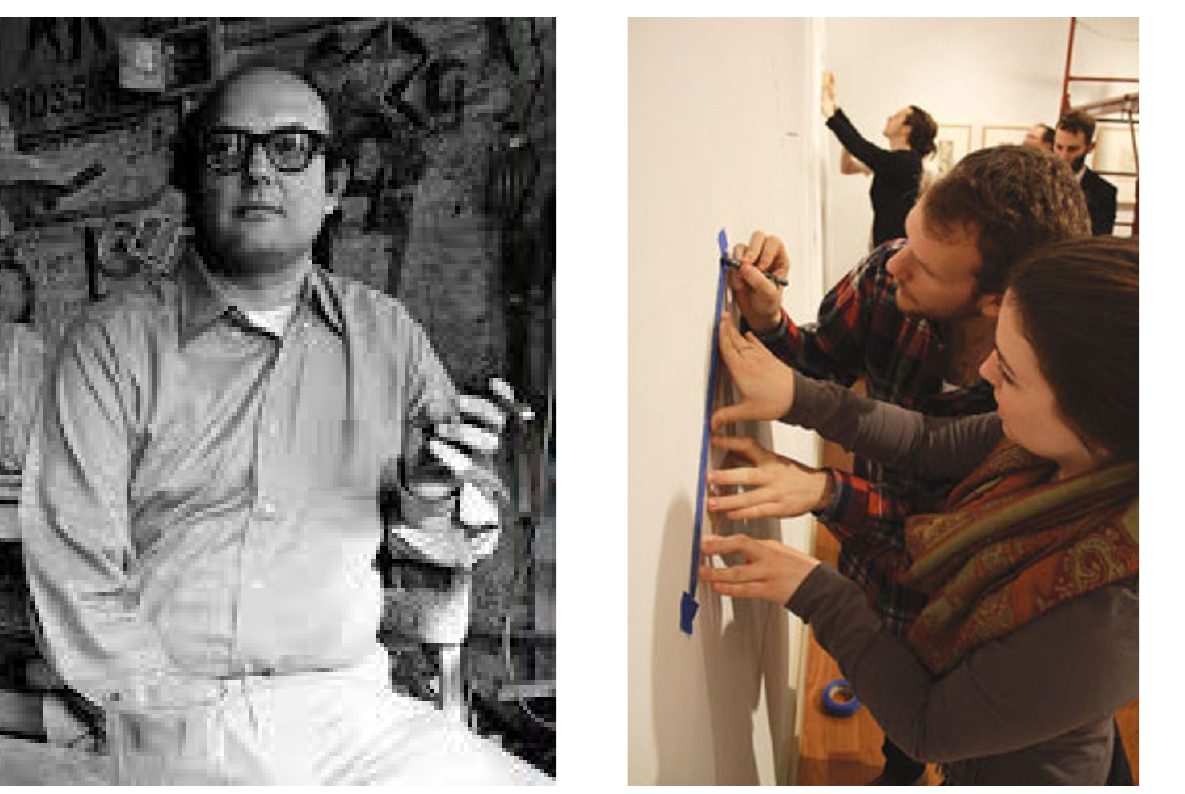
Figure 7 | Students carrying out a concept of Sol LeWitt's. Figure 6 | Sol LeWitt